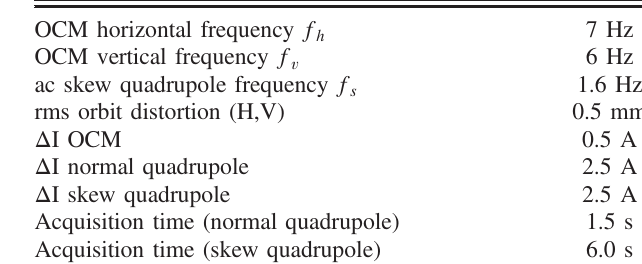
TABLE I. Summary of the optimized measurement parameters for which the expected buffer error in the evaluation of the offset is around 3 μ m, and the group error of about 1 μ m for the normal quadrupole case and 10 μ m in the skew quadrupole